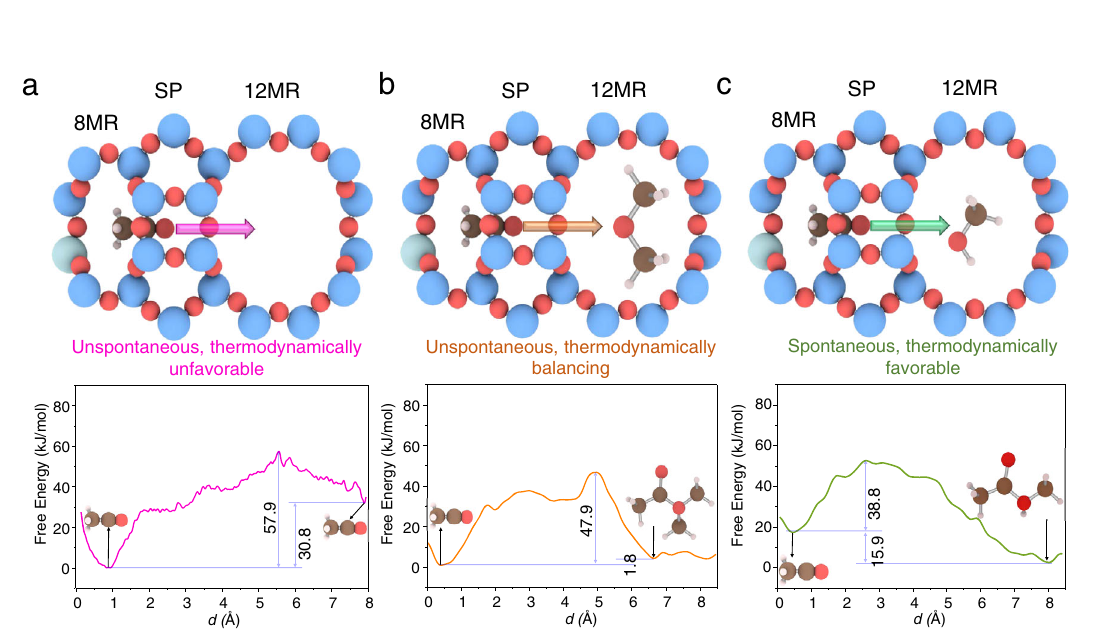
previously occupied by DME and the further formation of MAMe + , c free energy pro fi le of the movement of the acylium ion into the 12MR channel previously occupied by MeOH and the further formation of MAH +